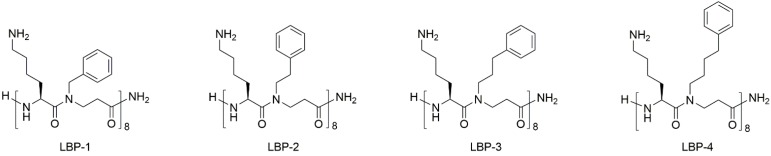
Structures of the peptidomimetics.